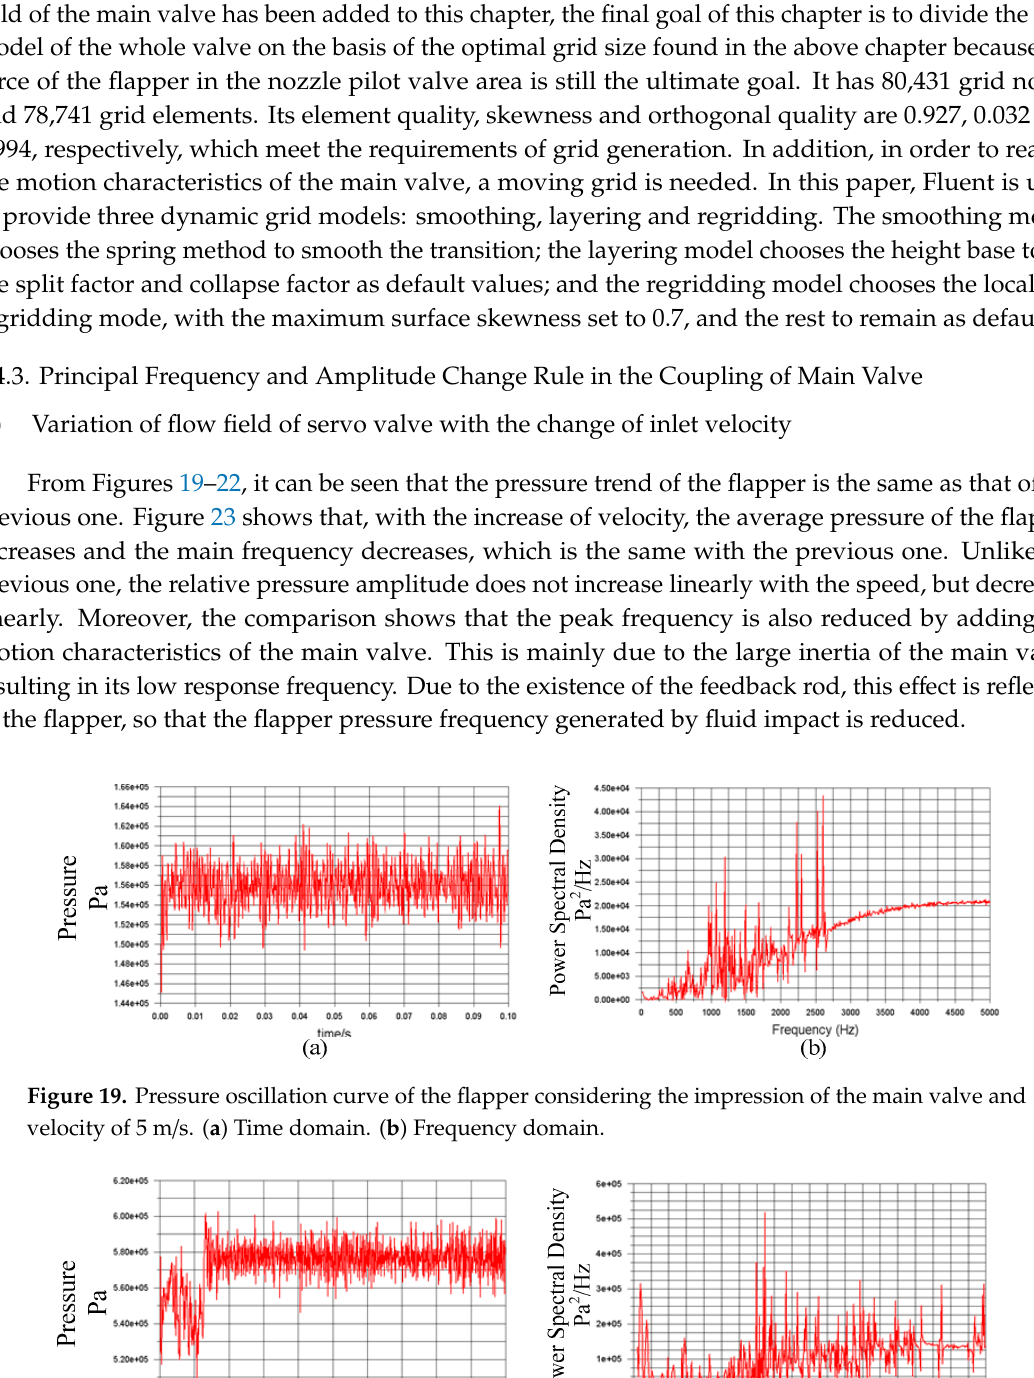
Figure 21. Pressure oscillation curve of the flapper considering the impression of the main valve and velocity of 25 m/s. ( a ) Time domain. ( b ) Frequency domain. Figure 22. Pressure oscillation curve of the flapper considering the impression of the main valve and velocity of 50 m/s. ( a ) Time domain. ( b ) Frequency domain.